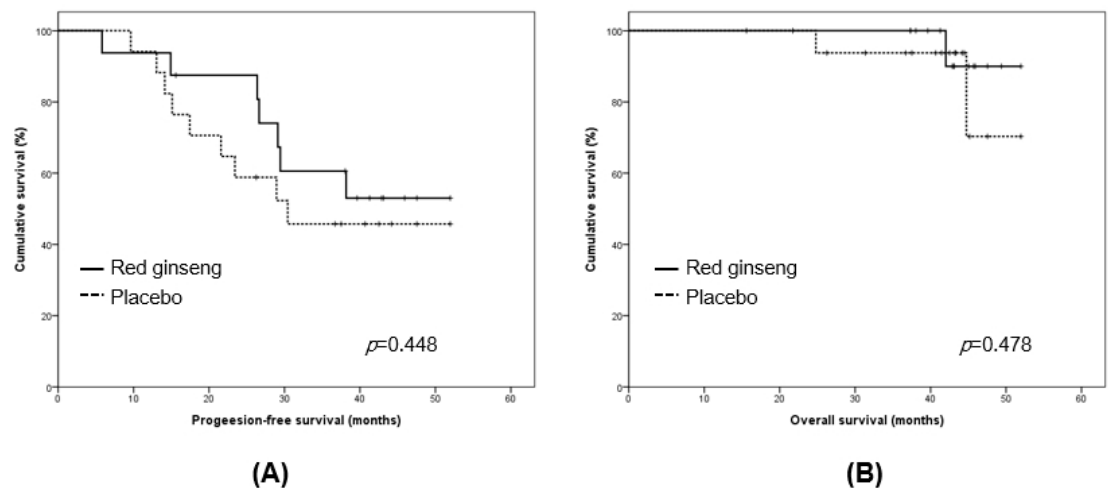
Figure 2. Comparison of ( A ) progression-free survival and ( B ) overall survival between placebo and red ginseng groups.